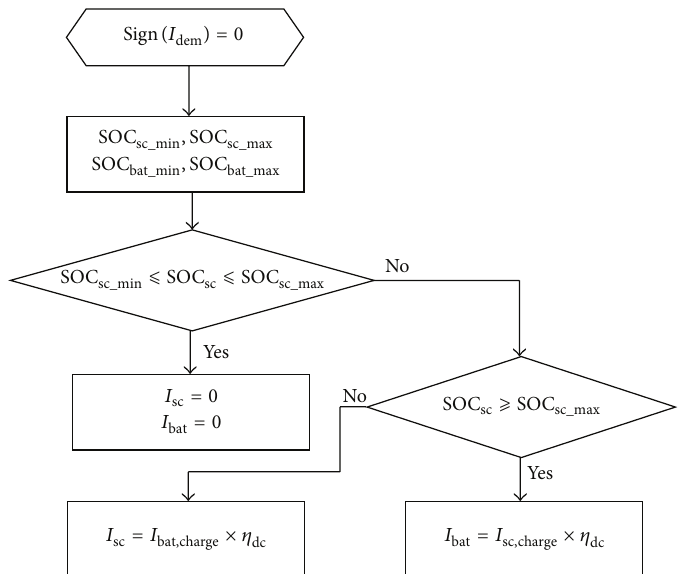
Figure 9: Flowchart of idle speed condition control mode.